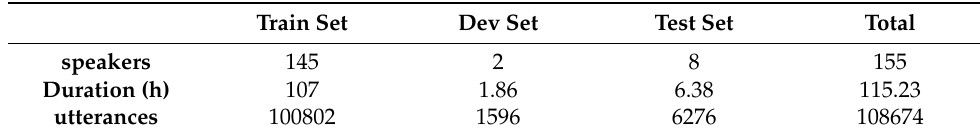
Table 1. Statistics of the SEAME